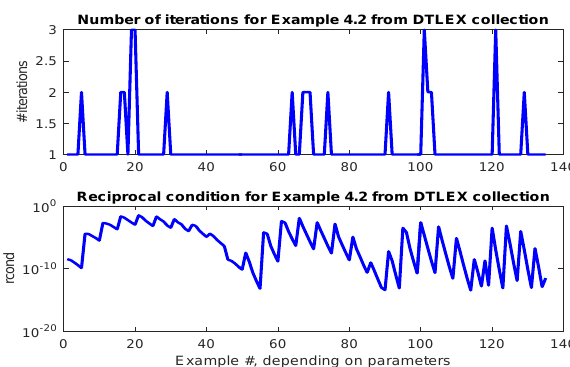
Figure 12. Normalized residuals for DTLEX 4.2 series of examples.